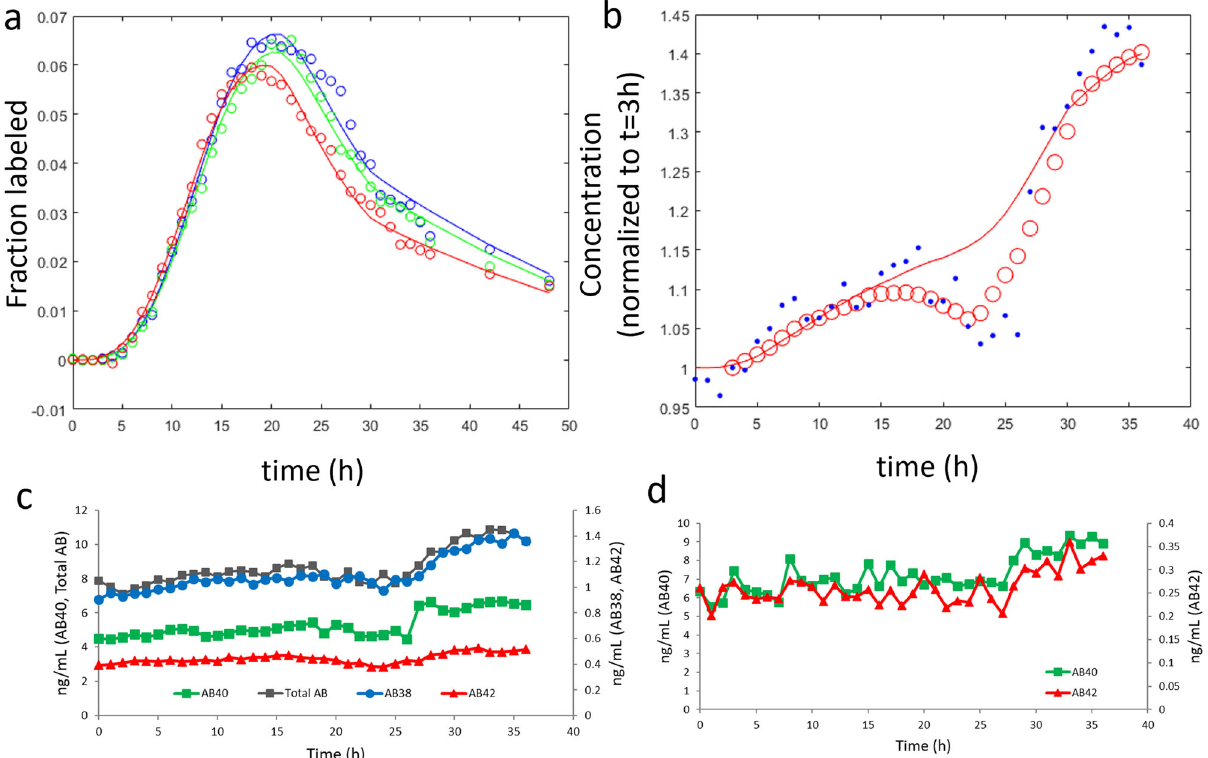
Fig. 3 Example of model fi ts to SILK and lumbar A β concentration. The physiological model fi ts with step changes in Q leak at 3 h and 20 h for a single amyloid-positive subject. a Fit of the physiological model to SILK data. Blue = A β 38 , green = A β 40 , red = A β 42 . b Fit of lumbar CSF concentration data (0 < time < 3, Q leak = 8 mL/h; 3 < time ≤ 20 h, Q leak = 0 mL/h; 20 ≤ time < 30 h, Q leak = 13 mL/h; time ≥ 30 h, Q leak = 0 mL/h). Blue circles = mass spectrometric measurements normalized to time = 3 h. Red circles = moving mean smoothed data. c Lumbar CSF concentrations were measured by immunoprecipitation followed by quantitative mass spectrometry, showing the abrupt change in concentration at about 27 h for all four peptides measured. d Lumbar CSF concentrations measured by ELISA also showed an abrupt change at about 27 h for both peptides